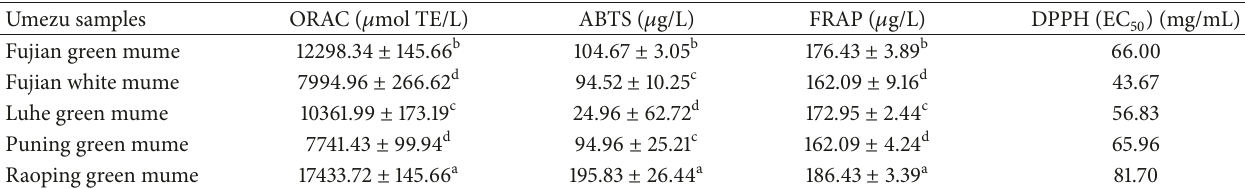
Table 4: Antioxidant activities of umezu from different